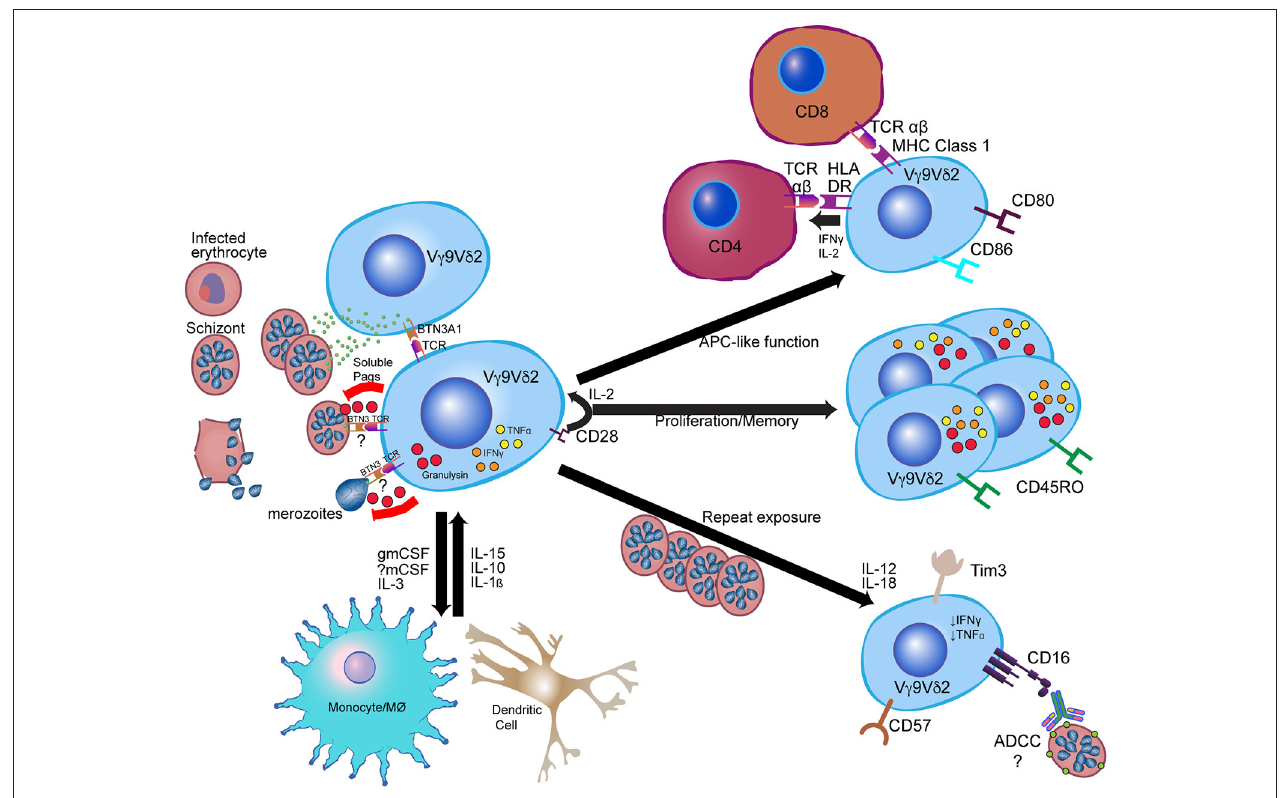
FIGURE 1 | Model for V γ 9V δ 2 γδ T cell response to Plasmodium falciparum .V γ 9V δ 2 γδ T cells recognize soluble phosphoantigens released from schizont stage parasites and potentially other iRBC stages. Though precise mechanisms of antigen presentation and recognition remain unclear, phosphoantigens are